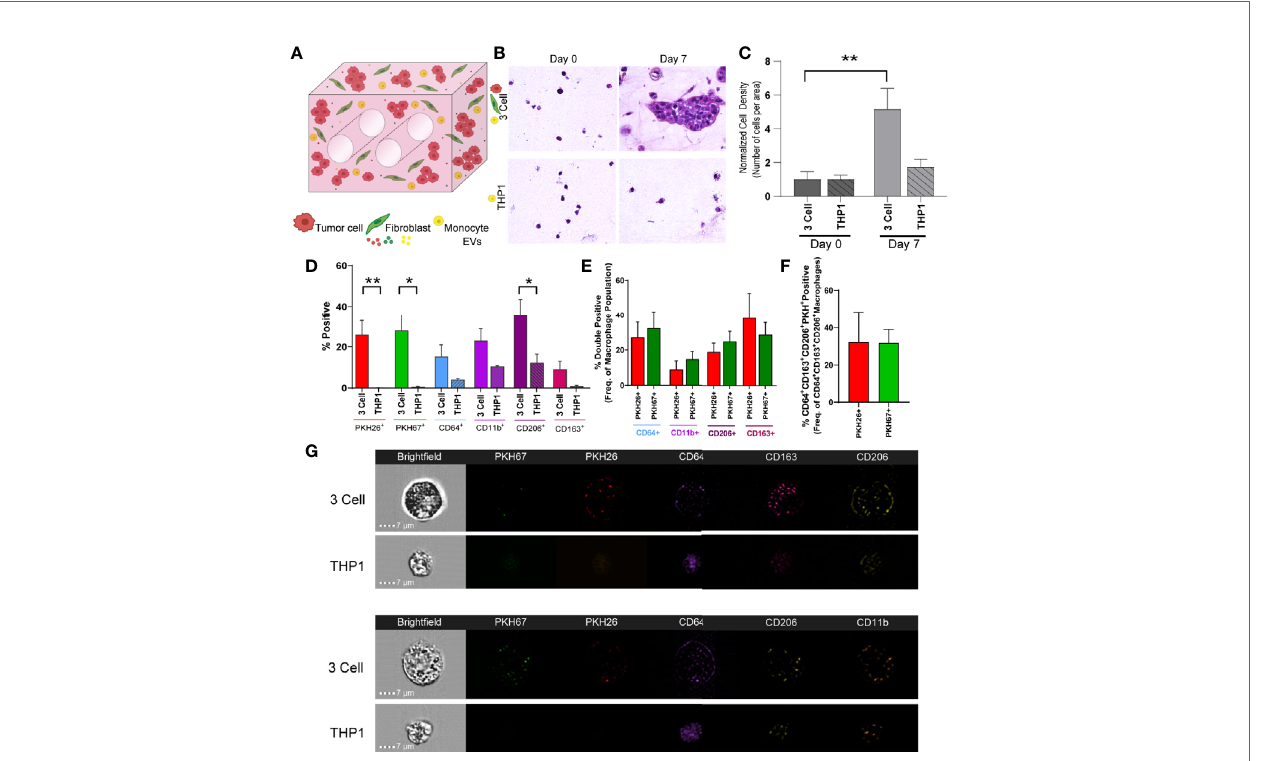
FIGURE 6 | Tumor Cells and Stromal Fibroblasts Polarize Monocytes within an Immune Cell Reconstituted Model of Lung Carcinoma. (A) Schematic showing immune cell reconstituted model (3 Cell) containing tumor cells (red), fi broblasts (green), and monocytes (THP-1, yellow). (B) Representative photomicrographs showing increased cell density within 3 cell tumor mimics (top) over time, compared to models containing only THP-1 cells (bottom). (C) Quanti fi cation of cell density, normalized to day 0, indicating cell growth within 3 cell tumor mimics. (D) Characterization of cell populations within 3 cell and THP-1 bioreactors showing increased CD206+ cells within 3 Cell bioreactors compared to THP-1 bioreactor following 7 days culture. (E) Characterization of monocytes containing tumor derived material (indicated by PKH26 signal) or fi broblast-derived material (indicated by PKH 67 signal). (F) No signi fi cant difference is observed between PKH26 + (tumor cell-derived material transfer) and PKH67 + ( fi broblast-derived material transfer) M2 like macrophages (CD64 + CD163 + CD206 + ). n=3-9 replicates per condition. (G) Representative imagestrips showing PKH signal within THP-1 monocytes. *p<0.05,